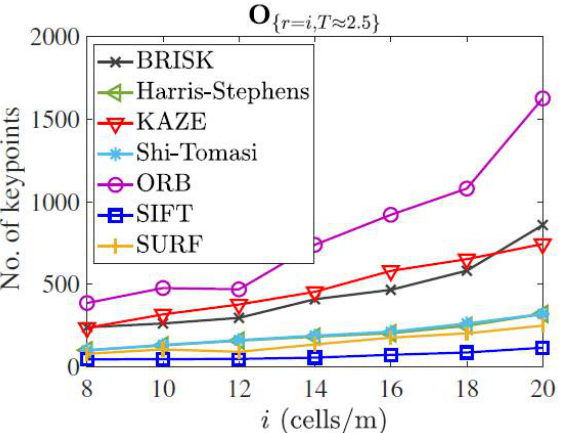
Figure 7. Extracted number of keypoints by different detectors in map O { r,T } for varying resolution ( r ) and scan rate ( T ).